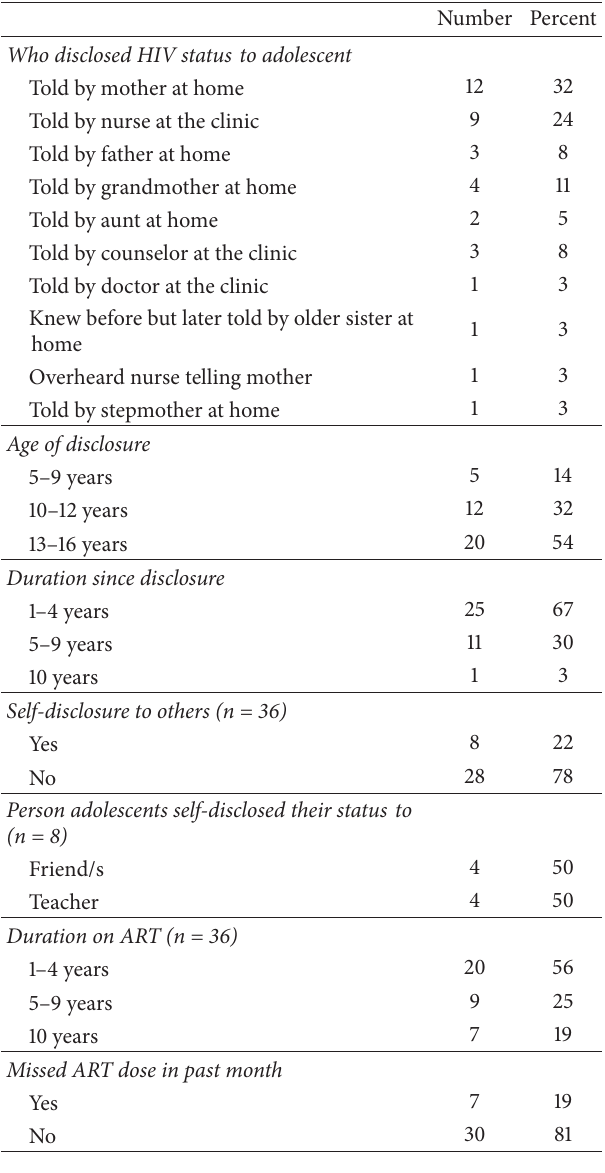
Table 2: Age of disclosure, self-disclosure, and person who dis- closed HIV status to the